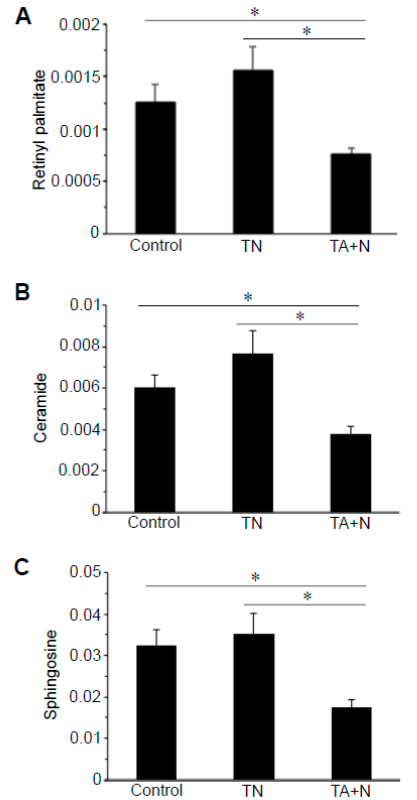
Figure 4. TA + N, but not TN, downregulates retinyl palmitate, ceramide, and sphingosine. Human pulmonary artery smooth muscle cells were treated with either TN (100 μ M) or TA (100 μ M) plus niacin (100 μ M) (TA + N) for 10 min. Samples were subjected to metabolomics analysis. ( A ) Retinyl palmitate, ( B ) ceramide, and ( C ) sphingosine were found to be differentially expressed between TN and TA + N groups. Bar graphs represent mean ± standard error of the mean (SEM) values of signal intensity. * Values are significantly different from each other at p < 0.05 ( n = 9).